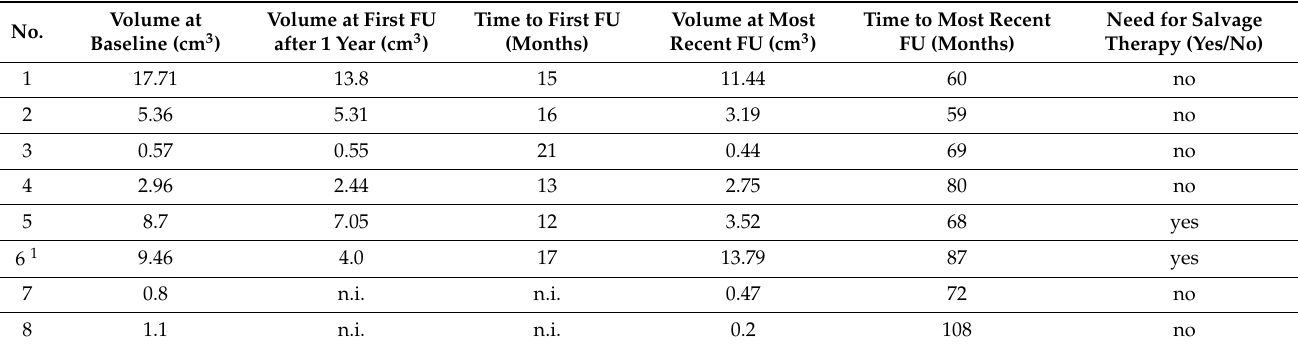
Table 3. Tumor volumetry after proton radiotherapy.